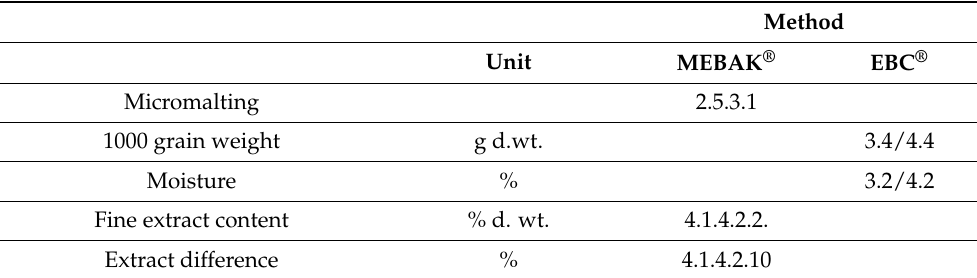
Table 1. Used Middle European Brewing Analysis Commission (MEBAK) and Analytica-European Brewery Convention (EBC) methods for the analysis of wheat and